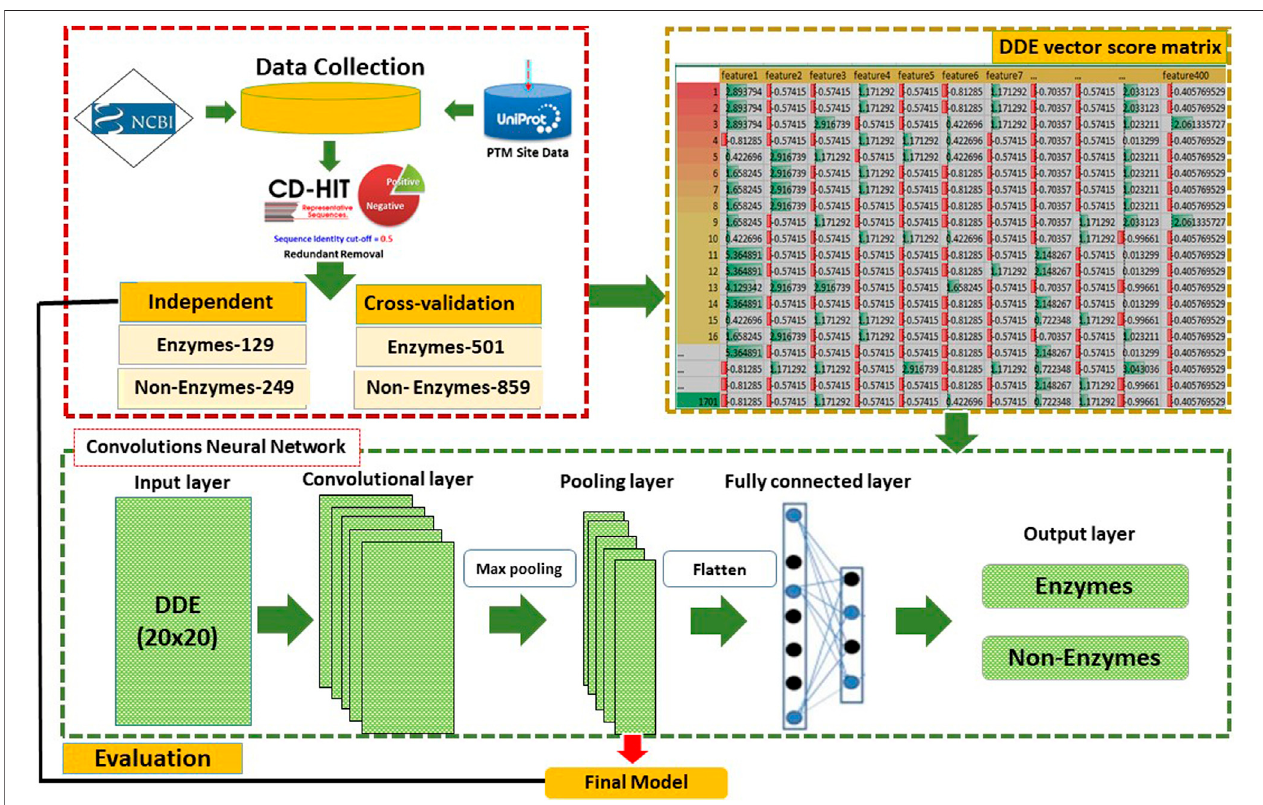
FIGURE 1 | Proposed framework model.